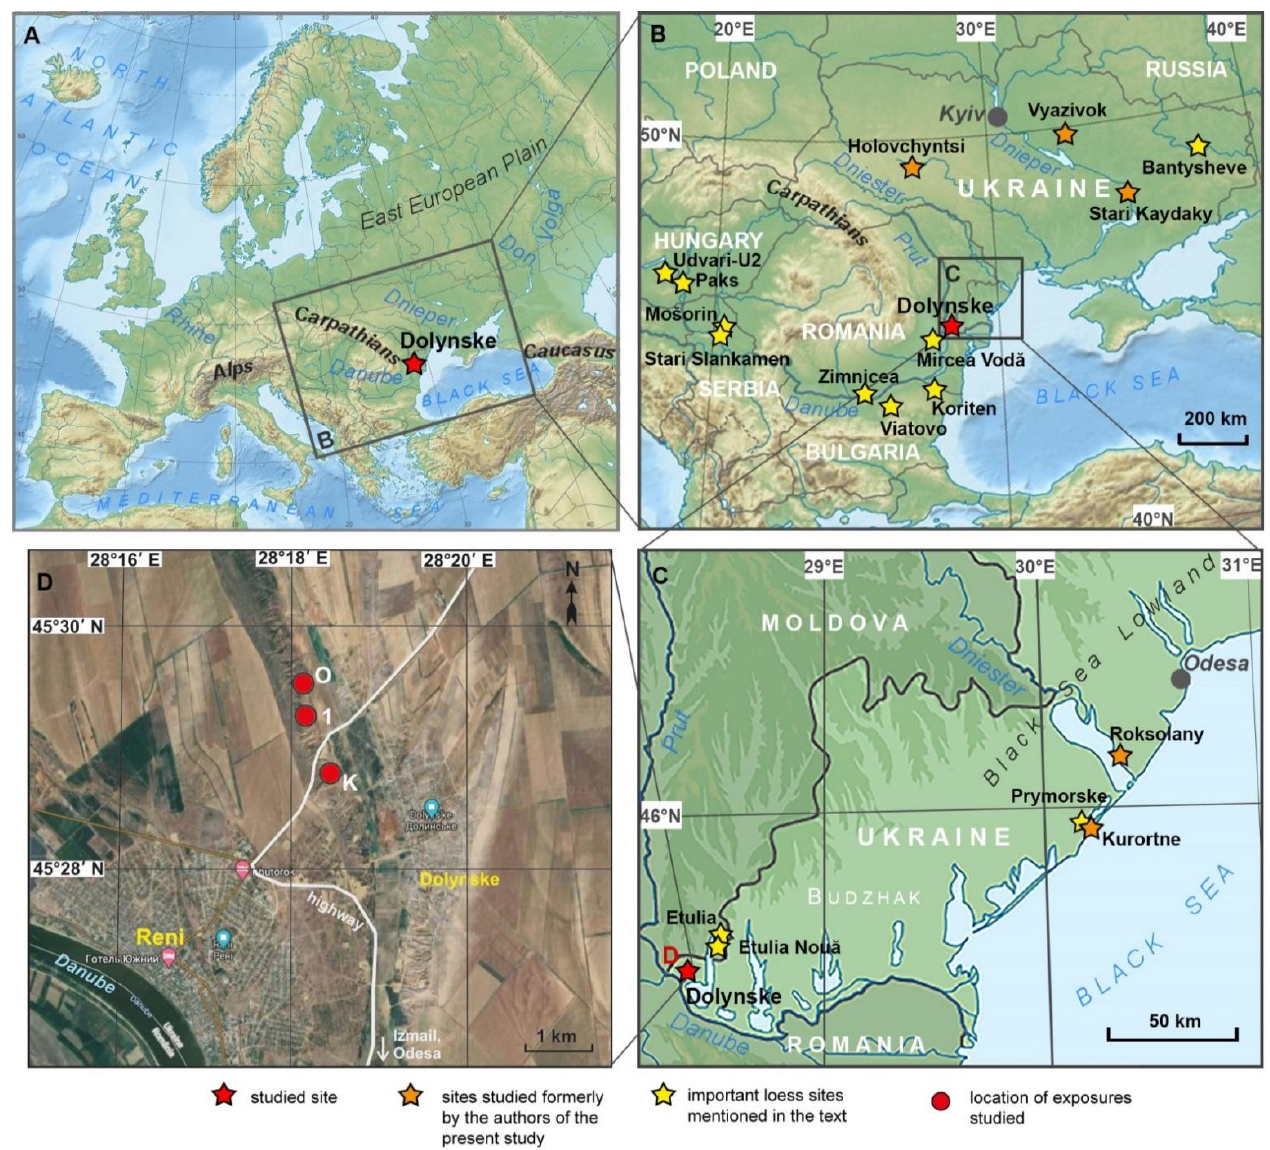
Figure 1. Location maps indicate the studied site: ( A ) Europe, ( B ) E-SE Europe, ( C ) Budzhak region, S Ukraine, and ( D ) exposures studied in the Dolynske area (adapted from: Wikimedia Commons and Google Maps).